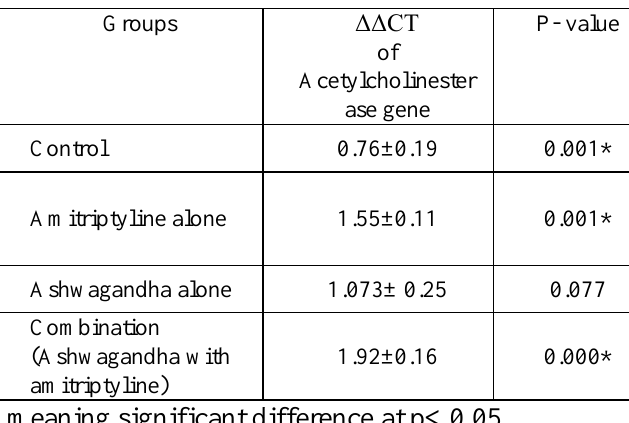
Table 2: The mean and standard deviation of Acetylcholinesterase gene expression in salivary glands